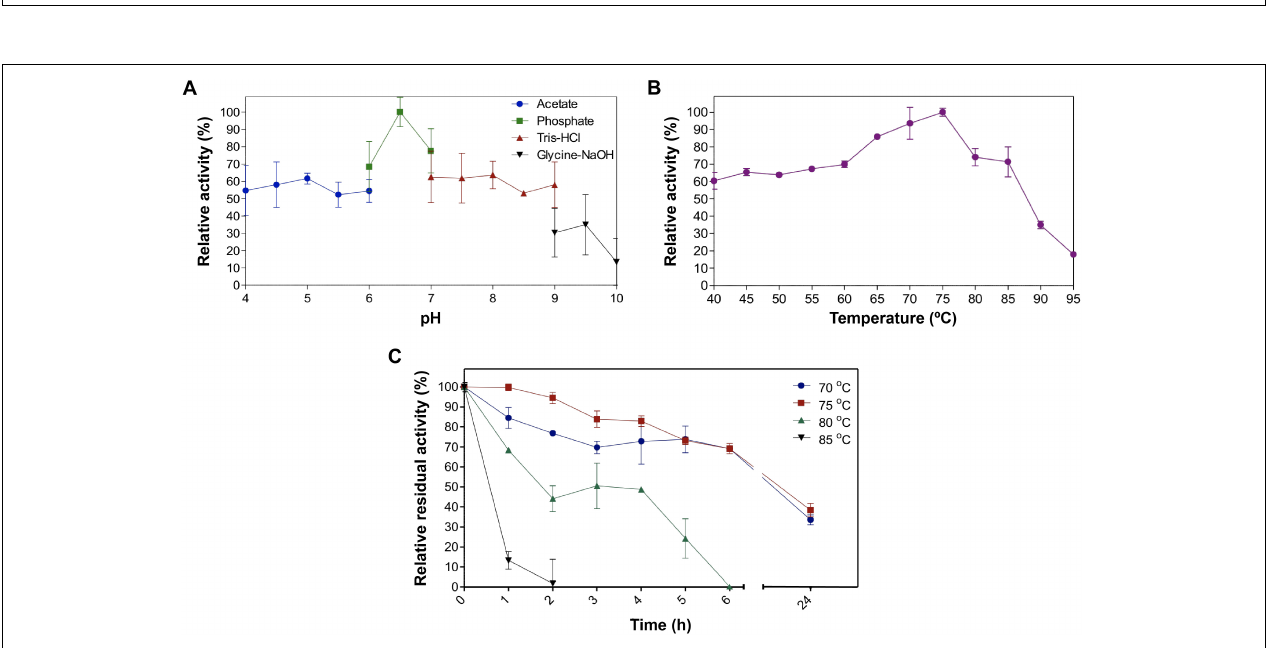
FIGURE 6 | Biochemical properties of EstDZ4. (A) Effect of pH on EstDZ4 activity. Enzymic activity was measured in the standard reaction, at pH values ranging from 4 to 10, using the indicated buffers. (B) Effect of temperature on EstDZ4 activity. Enzymic activity was measured at temperatures ranging from 40 to 95 ◦ C in the standard reaction. (C) Thermostability of EstDZ4 was evaluated by measurements of its esterolytic activity in the standard reaction after exposure to 75, 75, 80, and 85 ◦ C for up to 24 h. The reported values correspond to the mean value from three independent experiments performed in triplicate and the error bars to one standard deviation from the mean